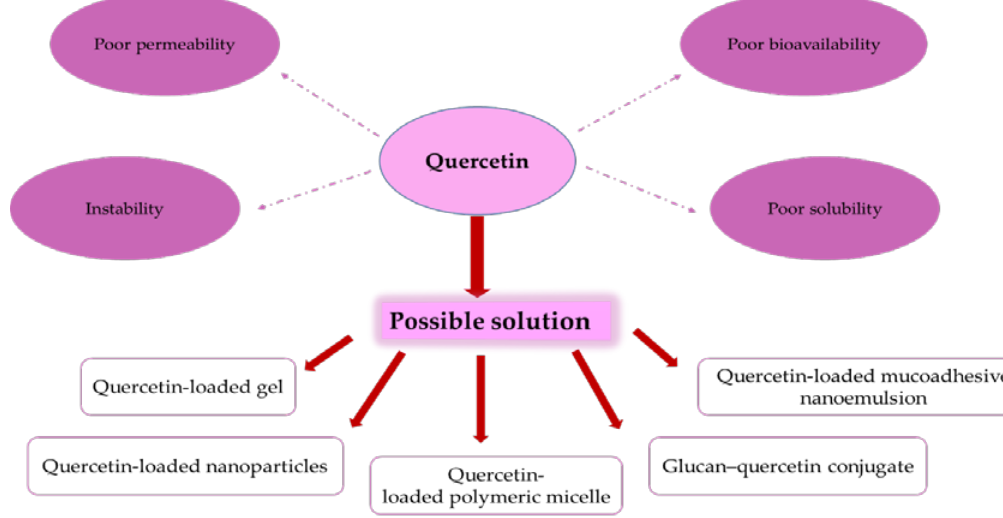
Figure 3. Quercetin formulations for improving its